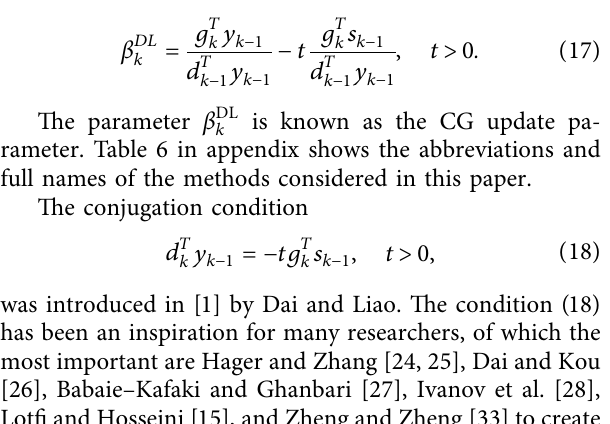
) � 1 + α − α 2 k k k for α k ∈